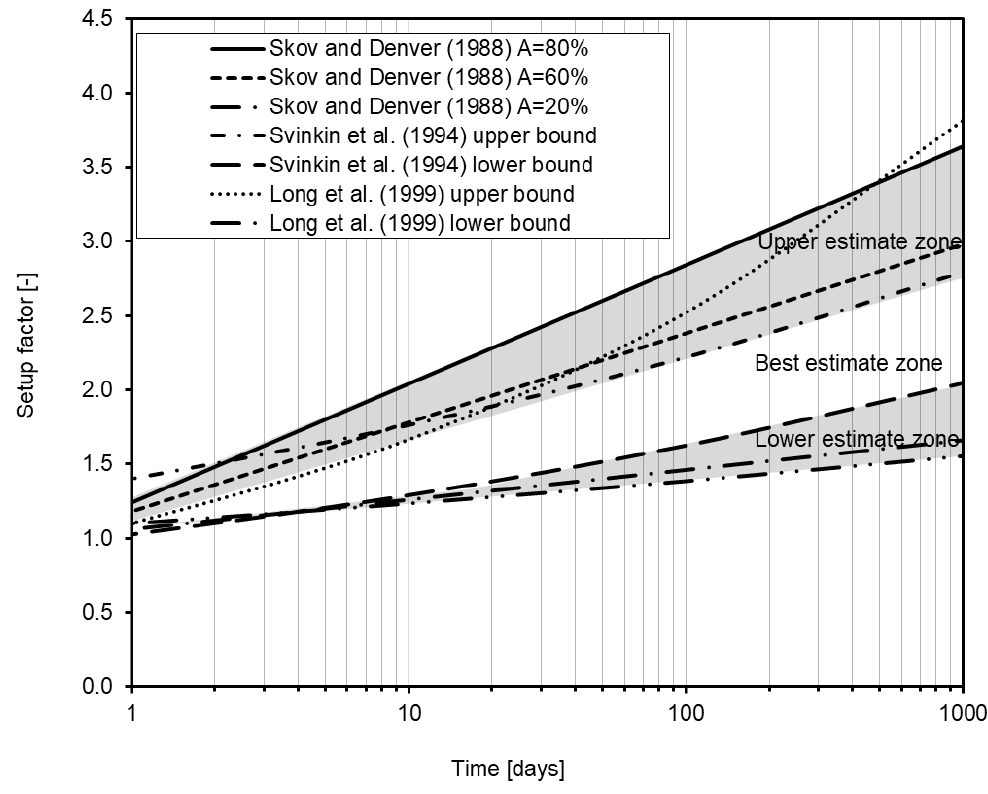
Figure 2 : Comparison of results of setup prediction models in Figure 2 . Comparison of results of setup prediction models in sand Table 1: Empirical models for predicting increase in bearing with